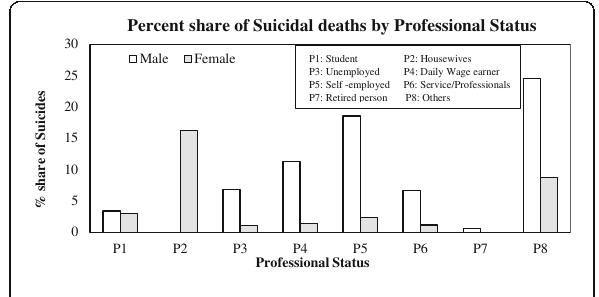
Fig. 7 Professional Status of Suicide Victims